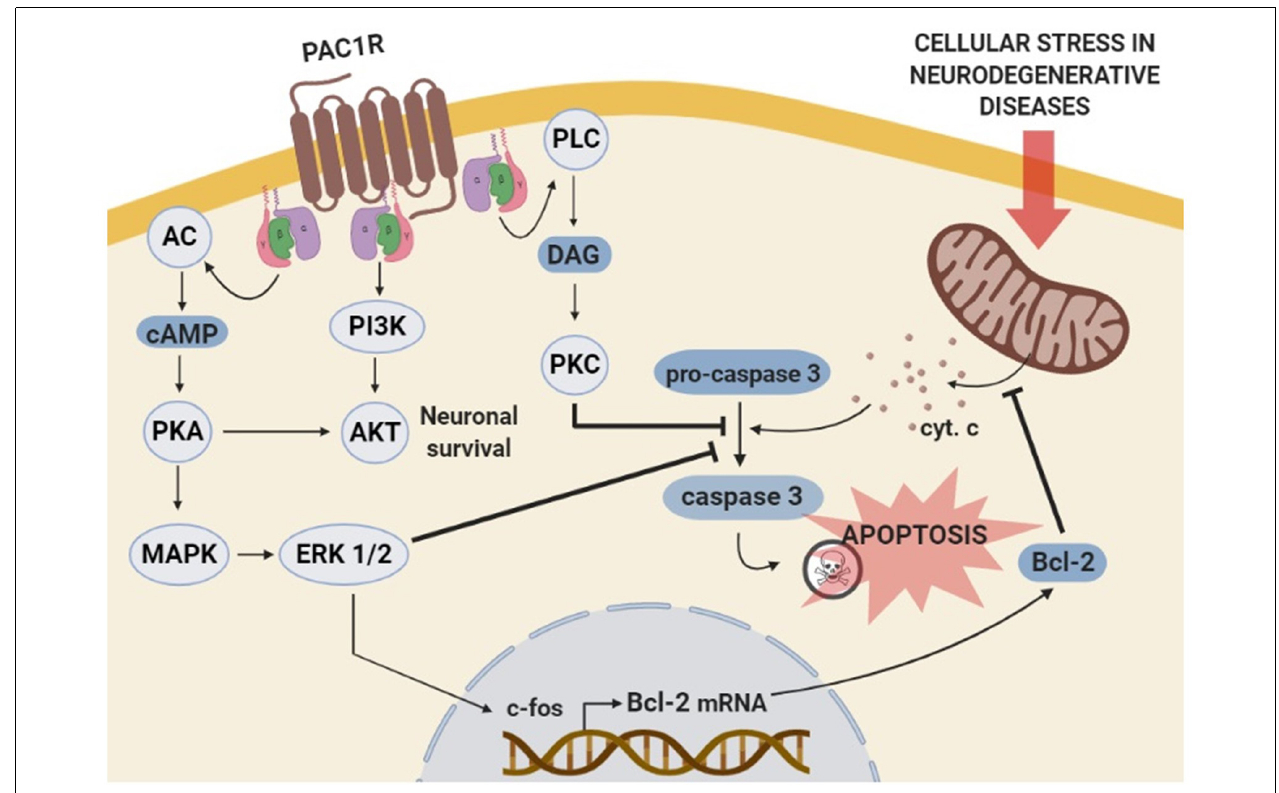
FIGURE 2 | Schematic representation of the molecular mechanisms involved in PAC1R mediated anti-apoptotic effect. The stimulation of PAC1R activates protein kinase A (PKA) cascade signaling, leading to extracellular signal-regulated kinase (ERK) phosphorylation. Activated ERK induces the transcription of neuroprotective genes such as c-fos and Bcl-2, which finally inhibits the mitochondrial apoptotic pathway and blocks pro-caspase-3 activation. The inhibitory effect of the PACAP-PAC1R system on pro-caspase-3 cleavage can be induced via additional phosoholipase C (PLC)/protein kinase C (PKC) pathway. Moreover, PAC1R can also activate phosphatidylinositol 3 kinase (PI3K)/Akt system and promote neuronal survival to counteract the apoptotic